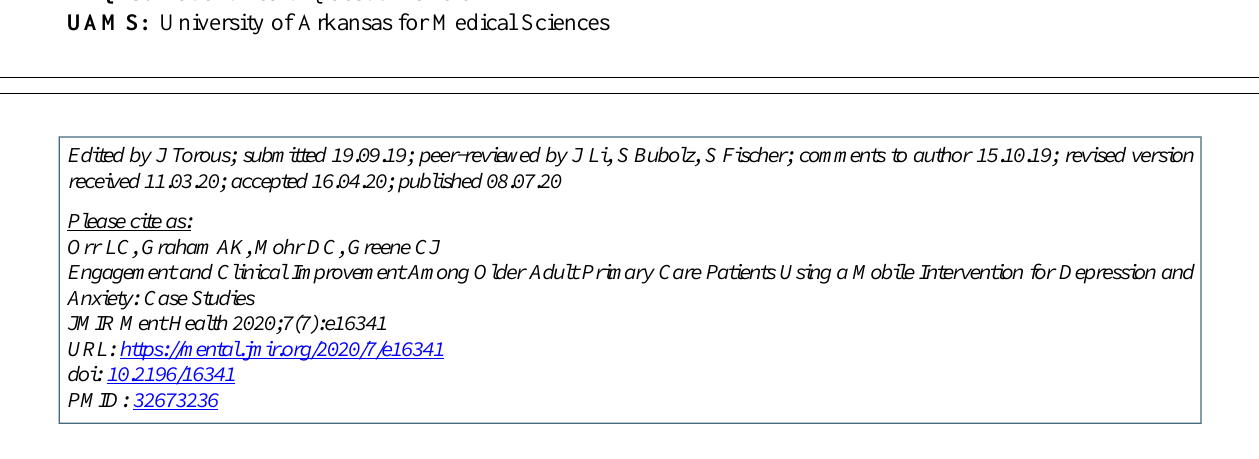
GAD-7: 7-item Generalized Anxiety Disorder scale PHQ-8: Patient Health